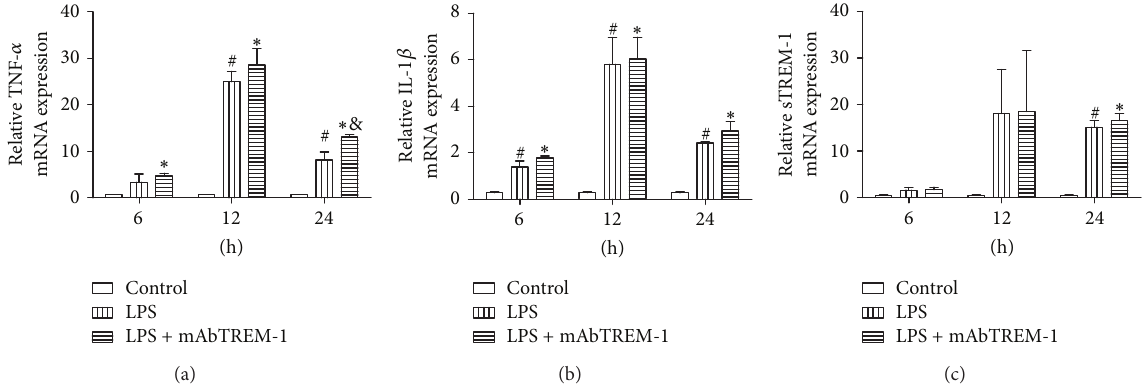
Figure 3: Myocardial TNF- 𝛼 (a), IL-1 𝛽 (b), and sTREM-1 (c) mRNA expression were assayed by quantitative real-time PCR among 3 groups at 6h, 12h, and 24 h as described in Materials and Methods; data are expressed as MEAN ± SEM; # 𝑃 < 0.05 compared with saline-treated mice, ∗ 𝑃 < 0.05 compared with saline-treated mice, and & 𝑃 < 0.05 compared with LPS-treated